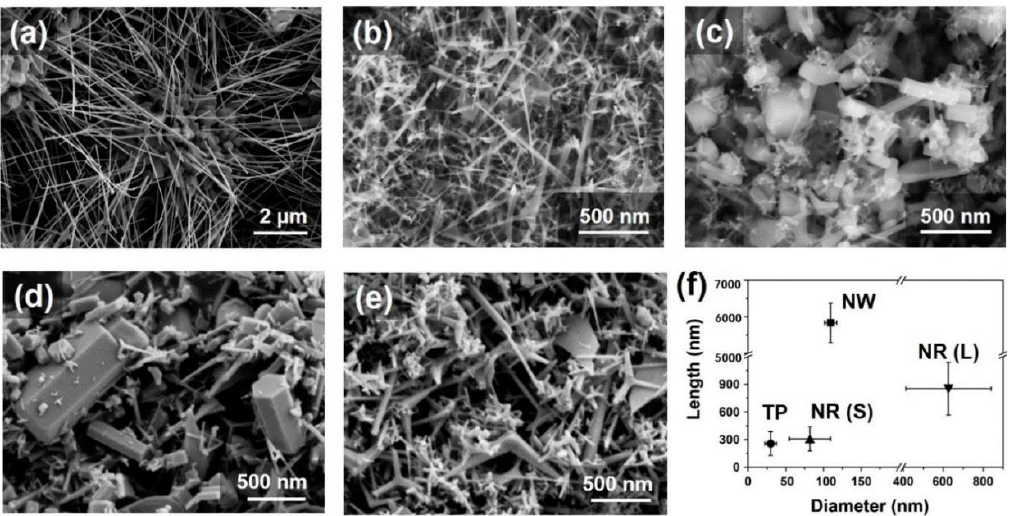
Figure 69. SEM images of synthesised ZnO nanomaterials using ( a , b ) compressed air, ( c ) high-purity air, ( d ) O 2 , and ( e ) O 2 / N 2 mixed gas. ( f ) Diagram shows length versus diameter of synthesised ZnO nanomaterials (NW; nanowire, TP; tetrapod, and NR (S), (L); small and large nanorods). Products were synthesised using a microwave plasma torch system at the atmospheric pressure. Reprinted with permission from [883], Copyright © 2019 Lee et al., Article licensed under a CC BY 4.0, https://creativecommons.org/licenses/by/4.0/.